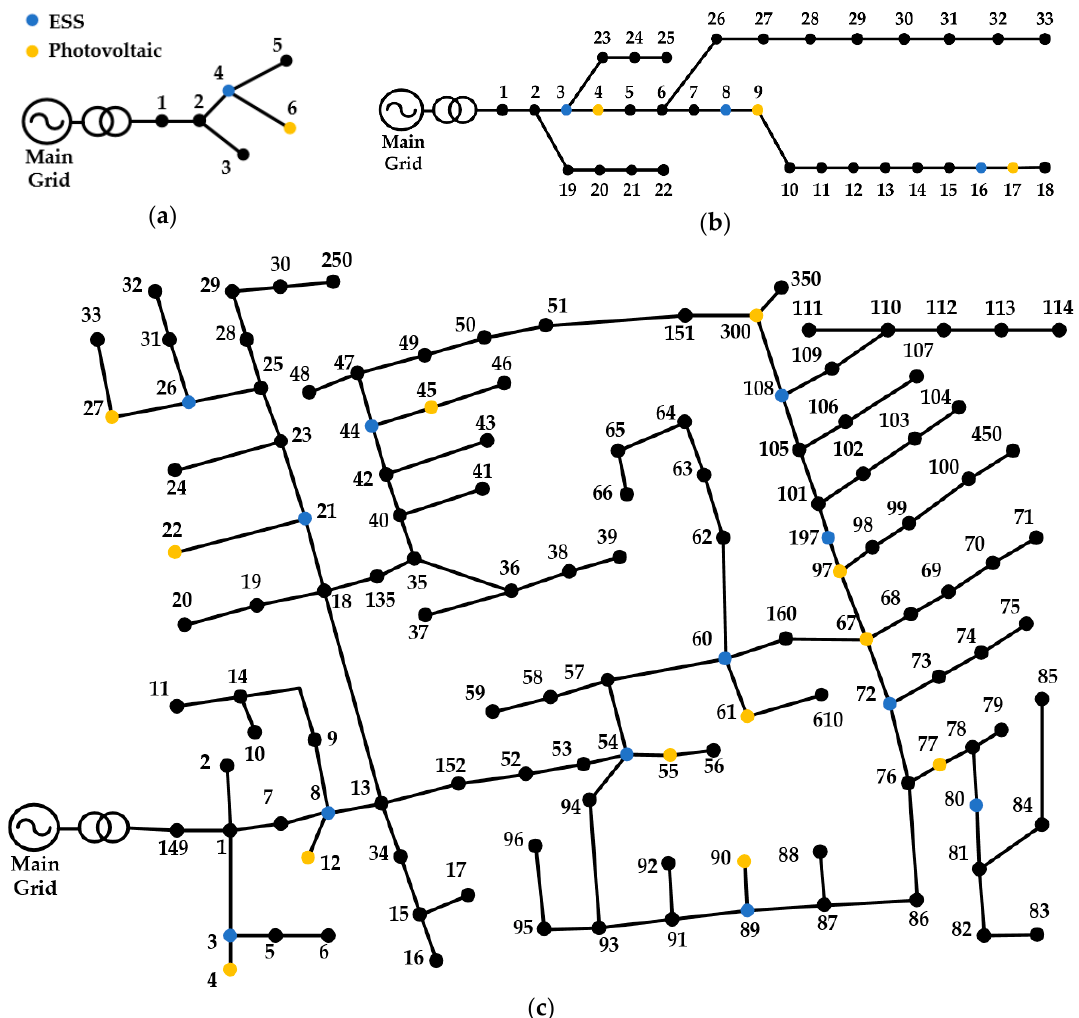
Figure 6. Grid-connected MGs for simulation case study. ( a ) 6-bus campus MG; ( b ) IEEE 33-bus radial test system; ( c ) IEEE 123-bus radial test system.